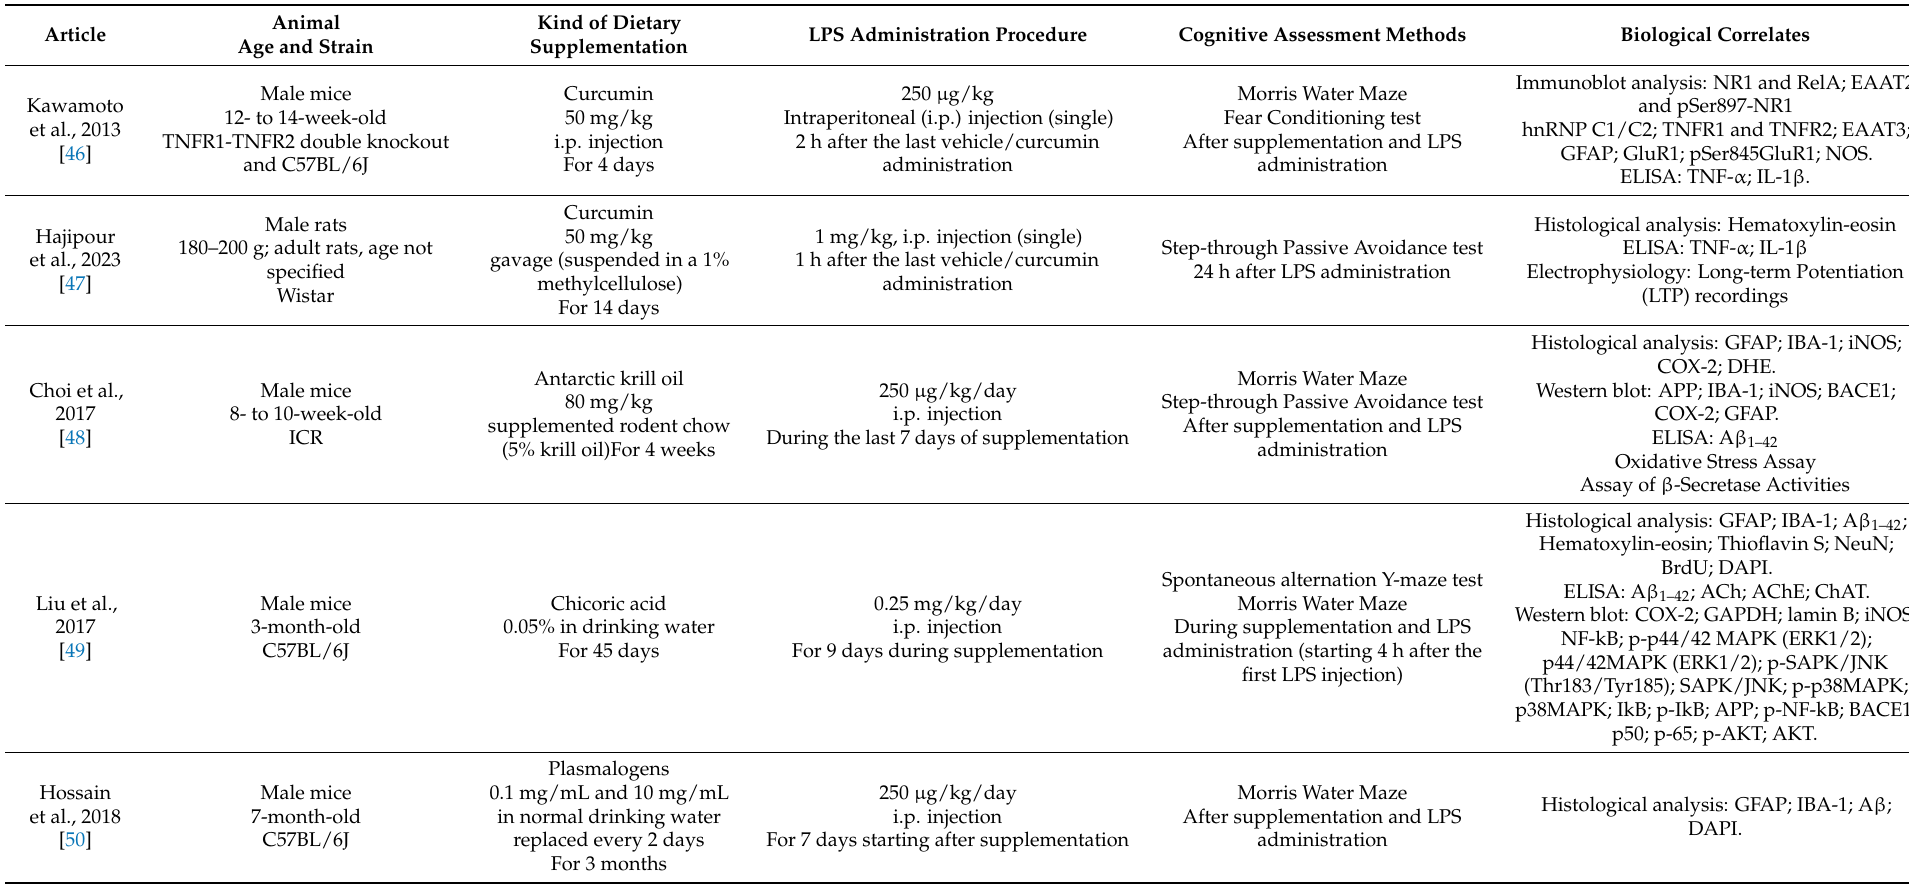
Table 1. Summary of the methodological approaches of the articles analyzed in the literature